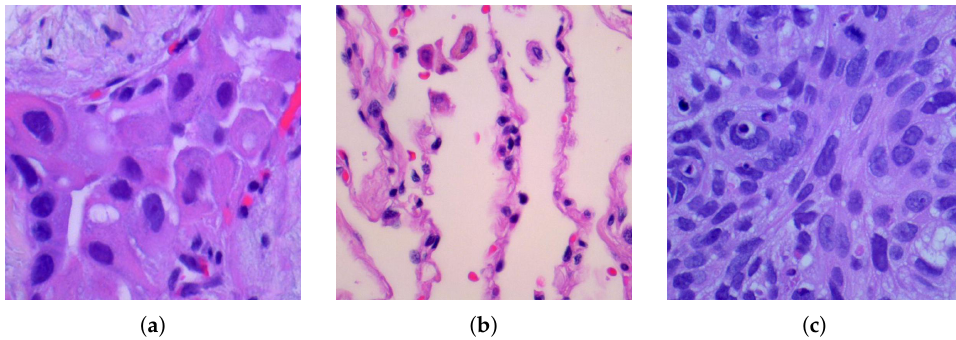
Figure 1. Three examples of different lung cancer classes from the original dataset with size 768 × 768: ( a ) lung adenocarcinoma, ( b ) lung benign, ( c ) lung squamous cell